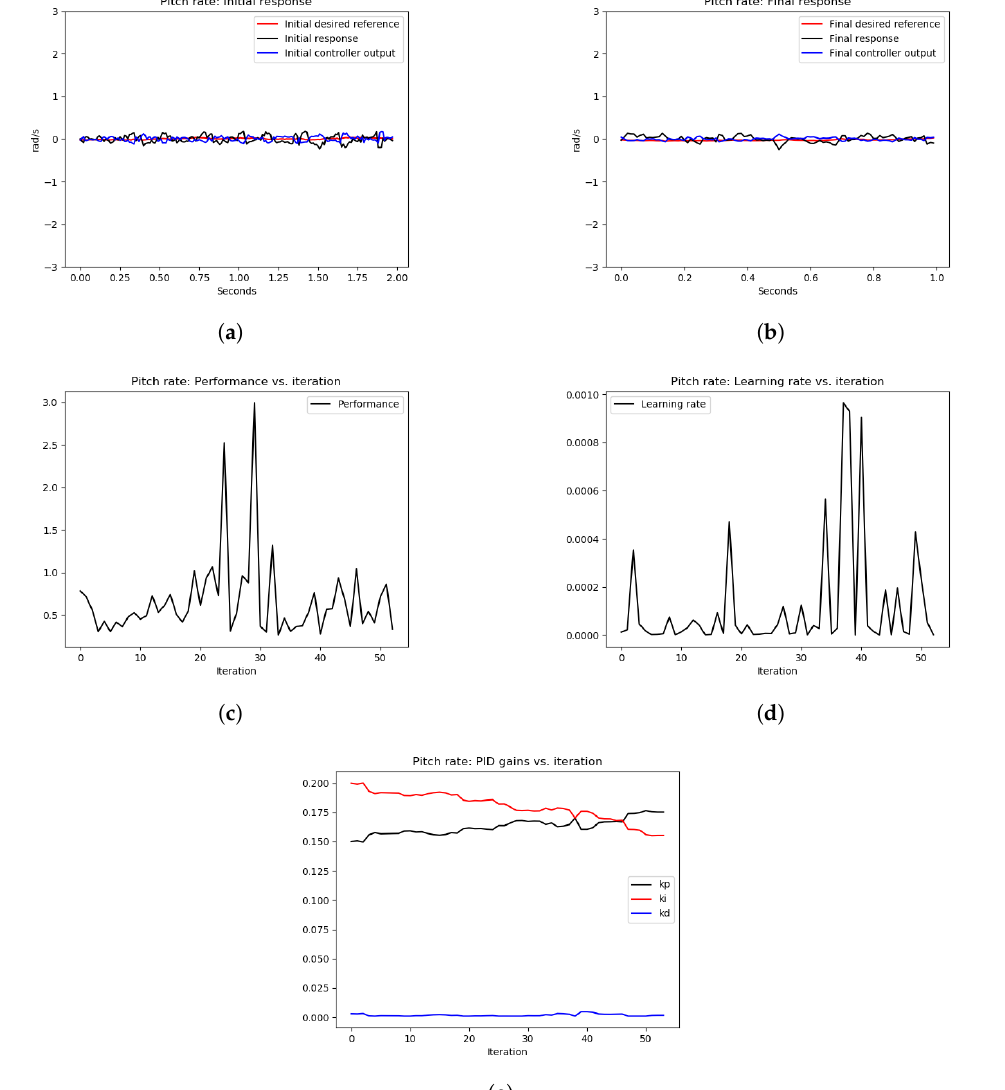
Figure 11. The results of the tuning process of the pitch rate PID controller in Experiment 1. ( a ) signals before tuning, ( b ) signals after tuning, ( c ) performance error V ( E ) over iterations, ( d ) learning rate α over tuning iterations, ( e ) PID